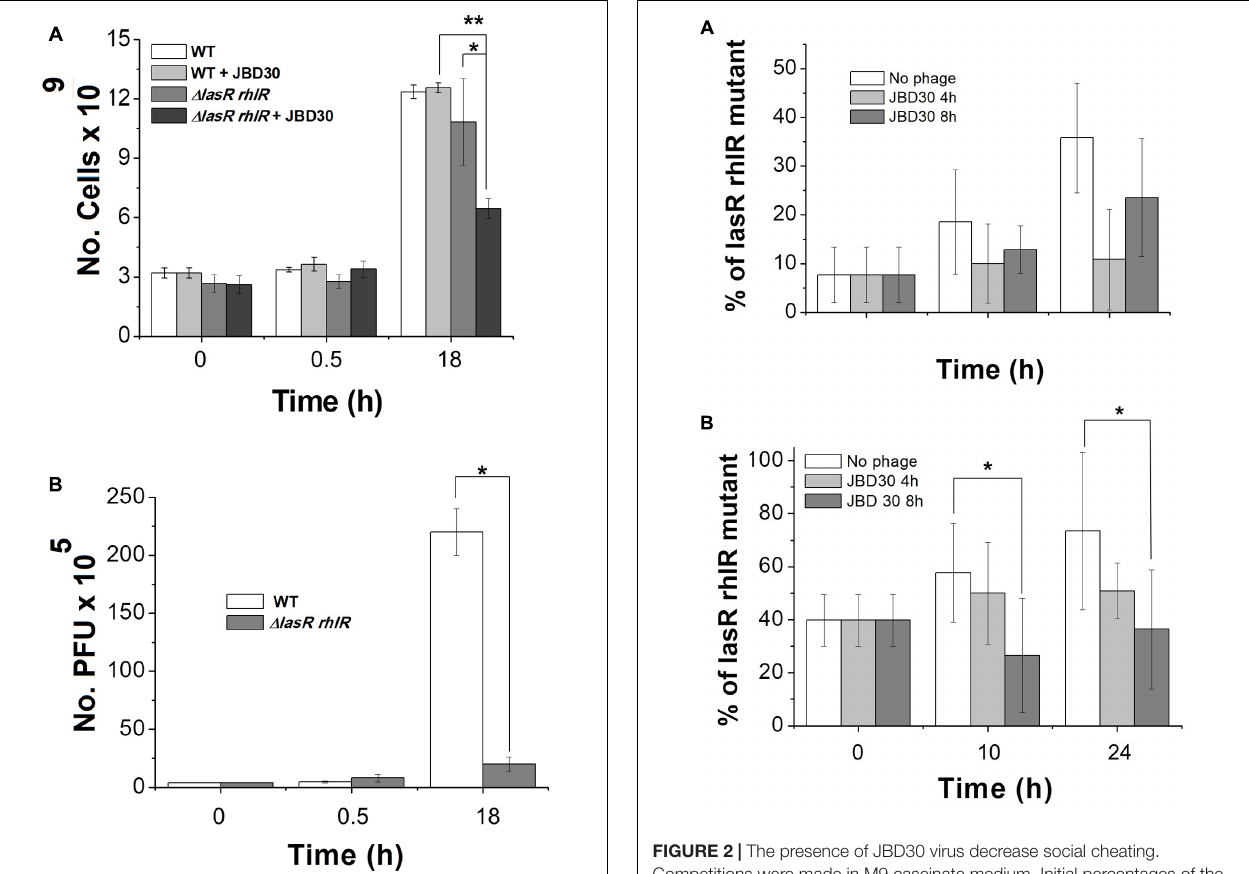
FIGURE 2 | The presence of JBD30 virus decrease social cheating. Competitions were made in M9 caseinate medium. Initial percentages of the lasR rhlR mutant were ∼ 10 (A) and ∼ 50 (B) . JBD30 phage (5 × 10 5 pfu) was added at either 4 h or 8 h after the beginning of the competences. Average of at least three independent cultures is shown. ∗ Indicate significant differences between experiments without phage and with phage, P < 0.01, in a two-tailed Student’s t